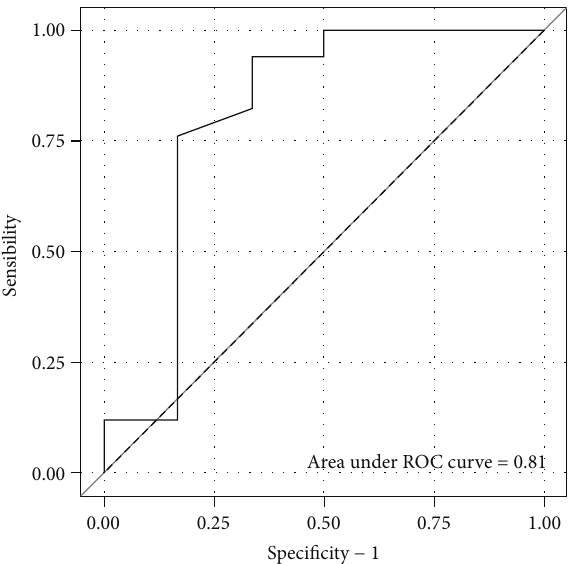
Figure 3: ROC curve for liver stiffness measurement predicting the presence of portal hypertension.